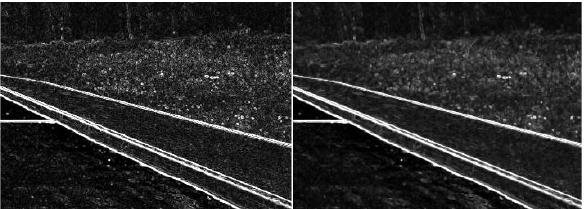
Figure 5. Adaptive noise